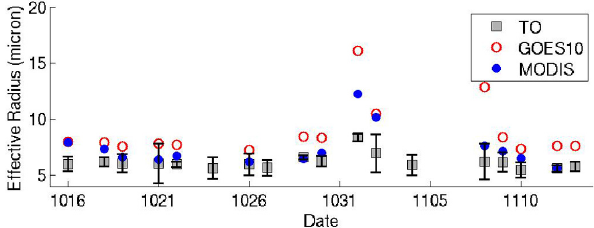
Fig. 14. R e from the near-cloud-top legs on all flight days. The standard deviations are indicated as the error bars. Red symbols are GOES retrievals averaged over an area within a radii of 20km of aircraft observations. Blue symbols are average Terra MODIS retrievals for a 0.5 ◦ region centered on Point Alpha taken at between 14:20 and